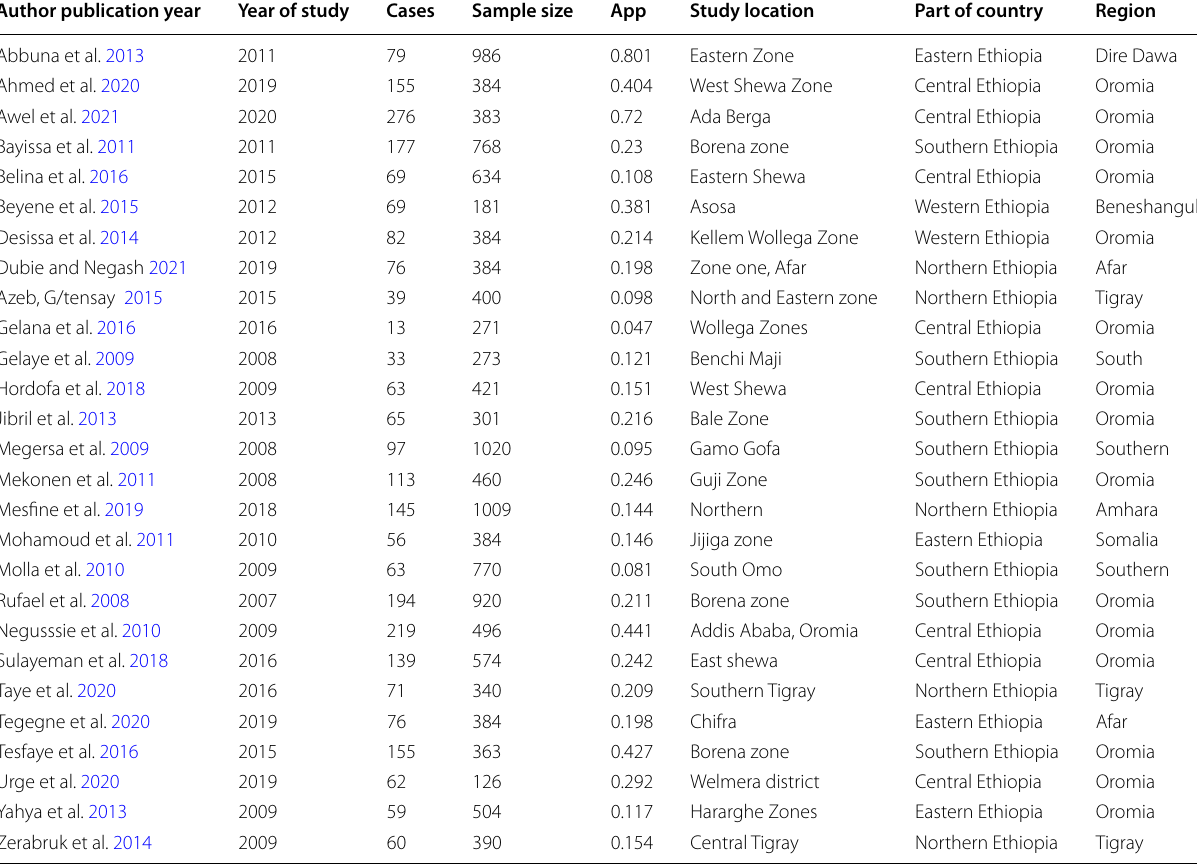
Table 1 Study articles comprised in a meta-analysis of foot and mouth disease in cattle in